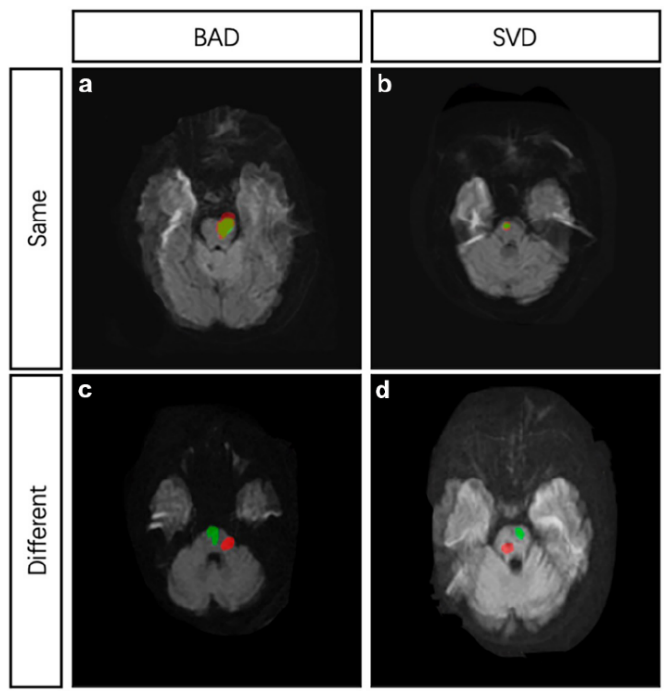
Figure 2. MRI demonstrations of four different conditions. ( a ), the index stroke and recurrent stroke were both attributed to BAD and located at the same site. ( b ), the index stroke and recurrent stroke were both attributed to SVD and located at the same site. ( c ), the index stroke and recurrent stroke were both attributed to BAD but located at different sites. ( d ), the index stroke and recurrent stroke were both attributed to SVD but located at different sites. Red area indicates the index infarction while green area indicates the recurrent infarction. BAD, branch atheromatous disease, SVD, small vessel disease.